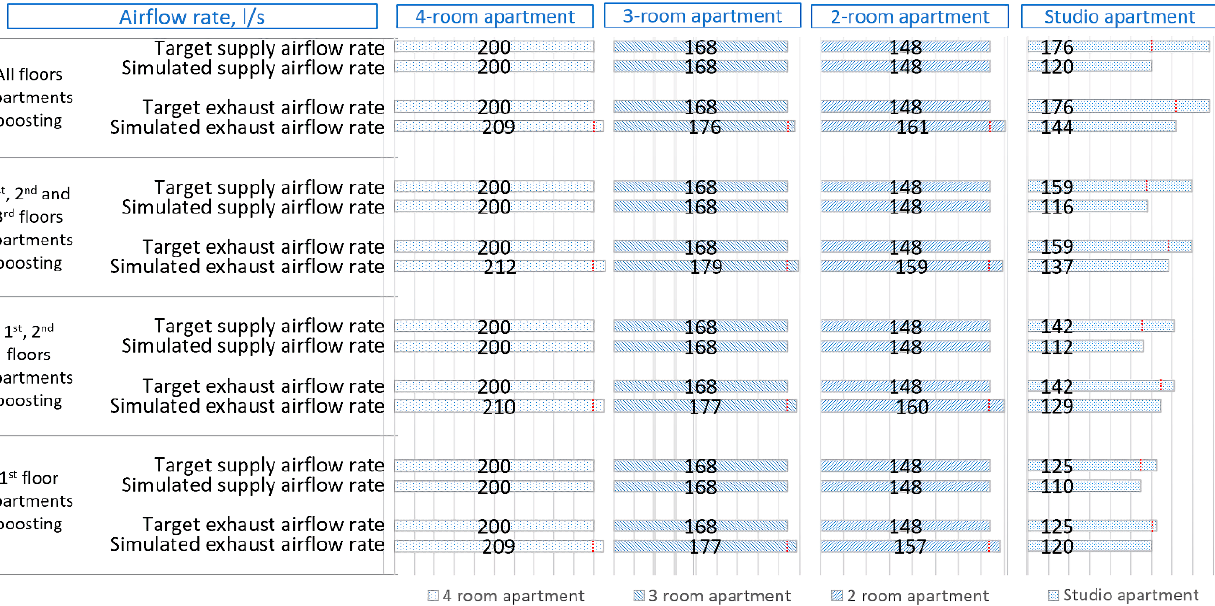
Figure 5. Target and simulated airflow rates at the AHU level when a different number of apartments are boosting.